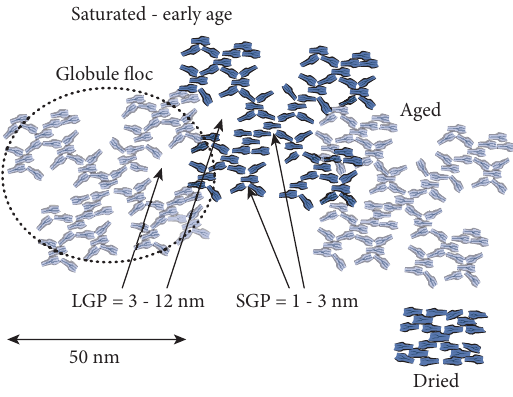
Figure 7: Rearrangement of C-(A-)S-H